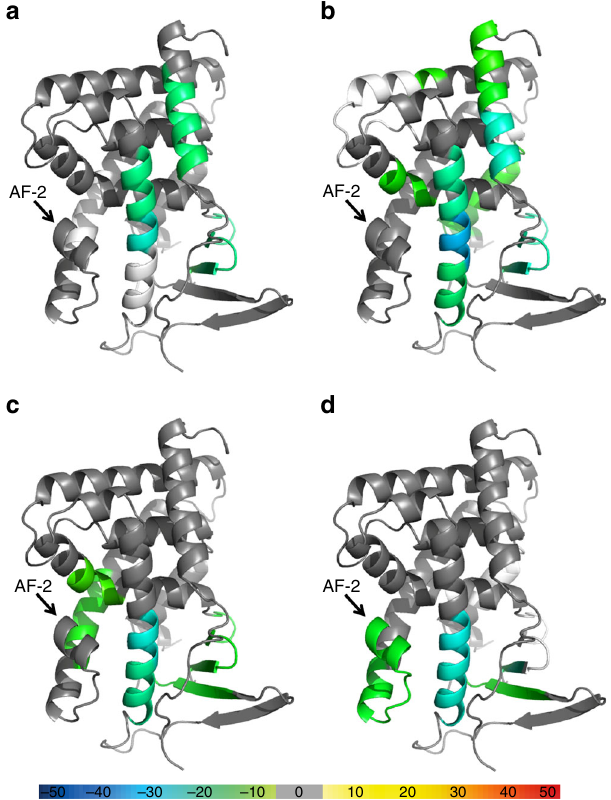
Fig. 6 HDX studies indicating structural rigidity changes in the hPXR LBD due to the presence of SJB7 and SPA70. Overlays of the differential HDX data onto the crystal structure of the hPXR LBD (PDB code 5X0R) for a SJB7, b SPA70 c SJB7 with the subsequent addition of SRC-1, and d SPA70 with the subsequent addition of NCoR. The structures are color-coded according to the color bar at the bottom of the fi gure. Regions that were not covered are represented in white . See Supplementary Fig. 8 for additional information on the color coding and score